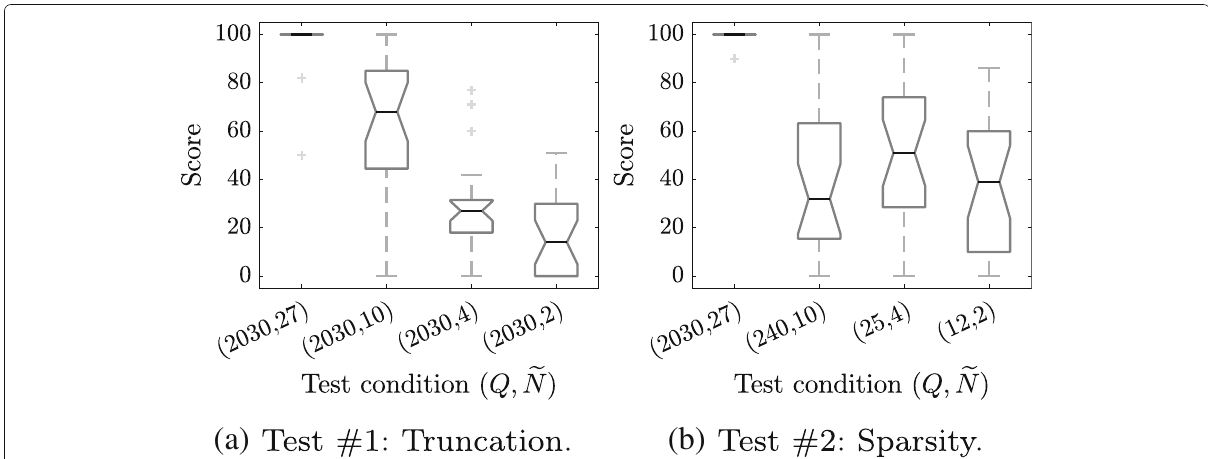
Fig. 7 Box plot of scores under truncation ( a ) and sparsity ( b ) conditions for loudnessstability evaluation. Each box represents a different ( Q , (cid:11) N ) condition. The box bounds the interquartile range (IQR) divided by the median, and Tukey-style whiskers extend to a maximum of 1.5 × IQR beyond the box. The notches refer to a 95% confidence interval